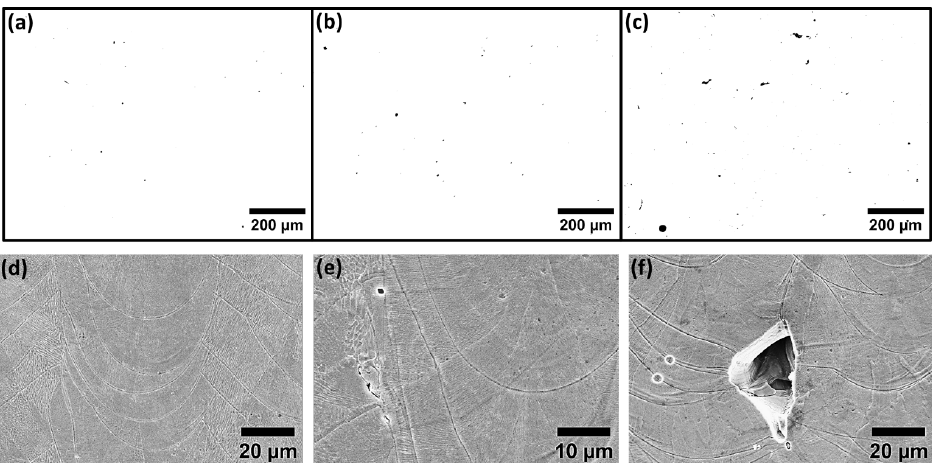
Figure 1. Optical and SEM microstructural analysis of L-PBF specimens of ( a , d ) group one, ( b , e ) group two, and ( c , f ) group three.